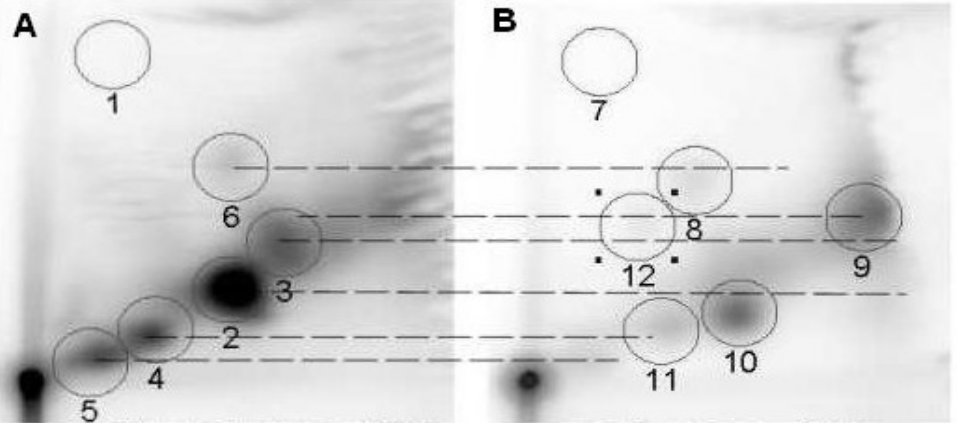
Figure 8: Autoradiogram of 32 P-postlabeled nuclease P1-treated calf thymus DNA from (A) photo-irradiation of the DNA in the presence of DMBA by UVA light (14 J/cm 2 ) and (B) the metabolite mixture from metabolism of DMBA by rat liver microsomes in the presence of calf thymus